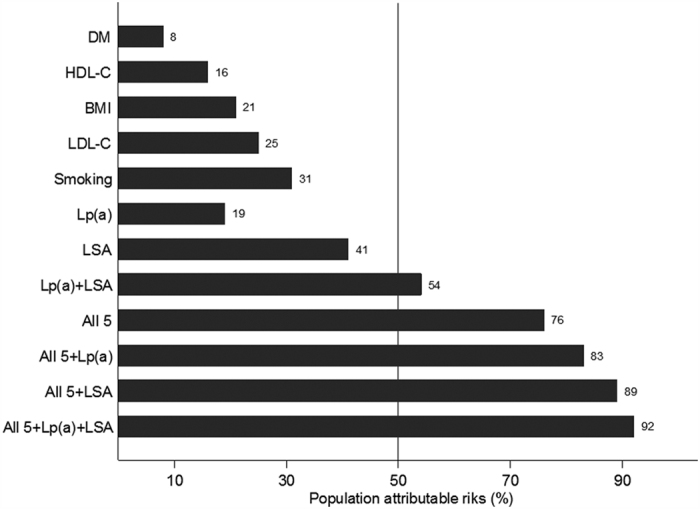
PARs of risk factors associated significantly with first incident AMI.All 5 indicated 5 conventional risk factors mentioned in this figure except Lp(a) and LSA. PAR calculations in combination or separately were all based on fully adjusted logistic regression model. Lp(a) accounted for 19% of PAR for first incident AMI; LSA, for 41%, and Lp(a) and LSA together, for 54%. The sum of separate Lp(a) and LSA PARs didn’t equal the combined PAR calculation for Lp(a) and LSA together, indicating the presence of overlap in contribution of Lp(a) and LSA. LSA and smoking were the 2 most important risk factors for AMI. The abbreviations as in Table 1.